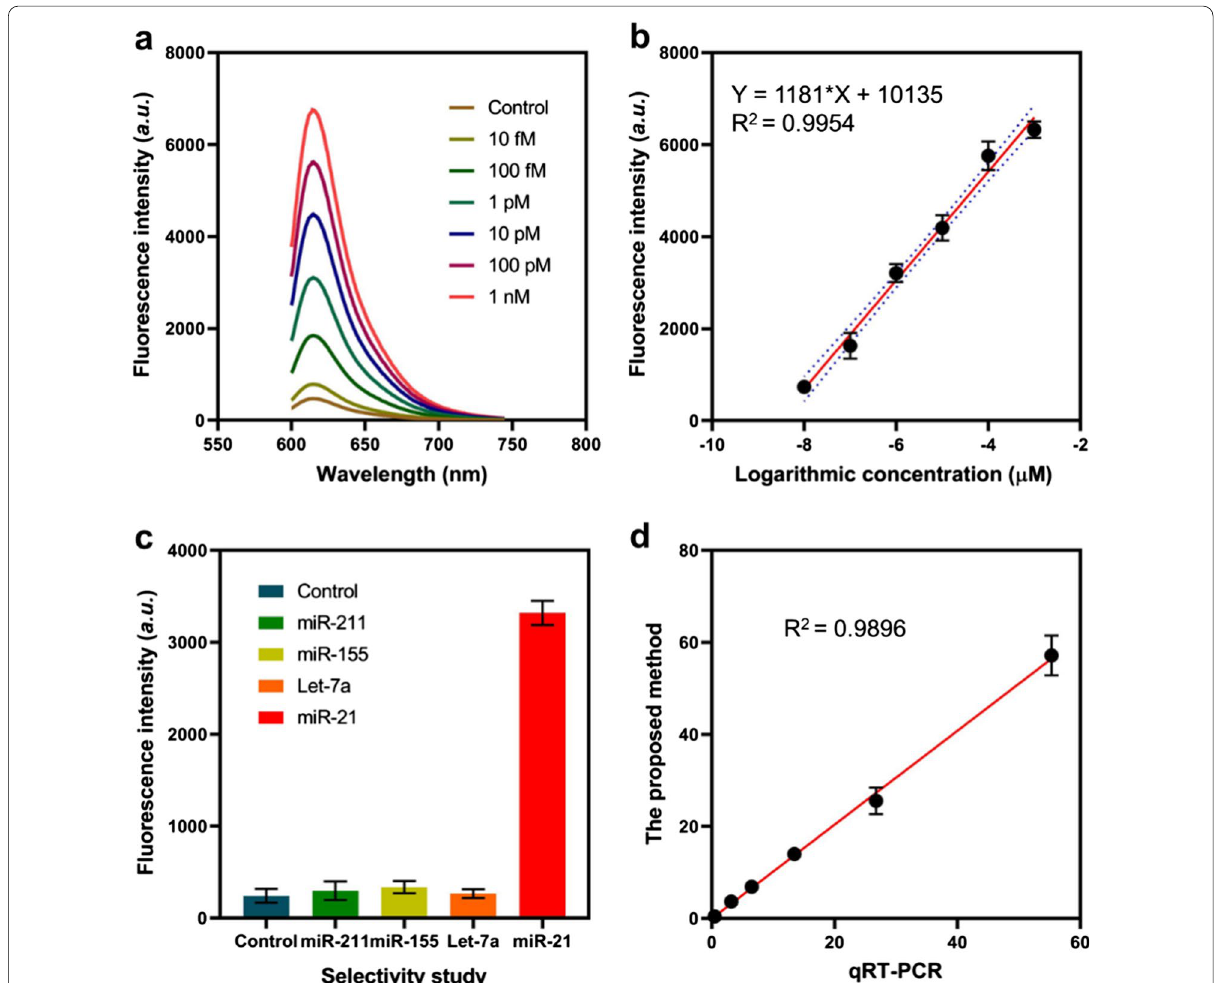
Fig. 3 Detection performance of the approach. a Fluorescence spectrum of the approach when detecting different concentrations of miRNA-21; b Correlation equation between peak value of fluorescence spectrum and the concentration of miRNA-21; c Fluorescence intensity of the approach when detecting different miRNAs; d Correlation of the calculated miRNA by the method and